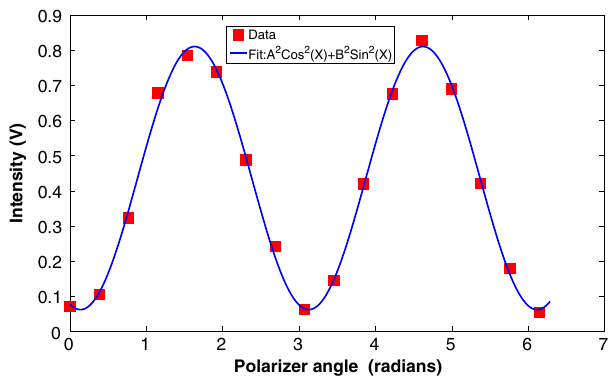
FIG. 4. The measured CSR intensity as a function of polarizer angle. While the sinusoidal behavior indicates a horizontally polarized CSR light, the nonzero baseline indicates the vertical polarization component of the CSR. The fit function is given by A 2 cos 2 ð X Þ þ B 2 sin 2 ð X Þ , where X ¼ W(cid:9) þ (cid:8) and W , (cid:8) , A , and B are arbitrary constants and (cid:9) is the polarizer angle in radians. From the fit we obtain W ¼ 1 : 0510 and (cid:8) ¼ (cid:4) 0 : 1429 radians.